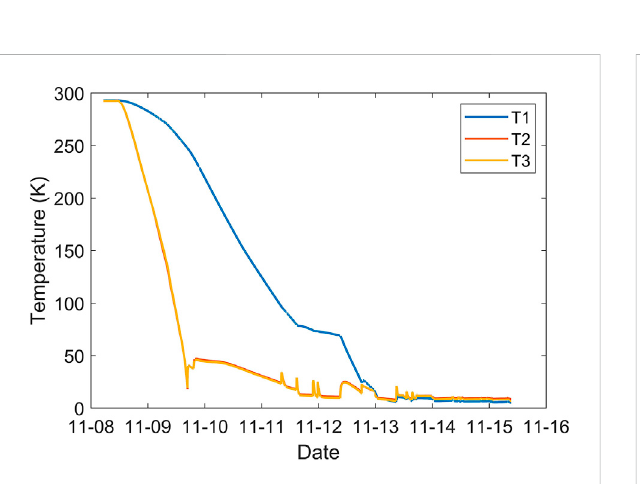
FIGURE 14 Cooling curves of the 1.5-m-long SCU in the cryostat. T1 for the magnet core; T2 and T3 for the two current leads.